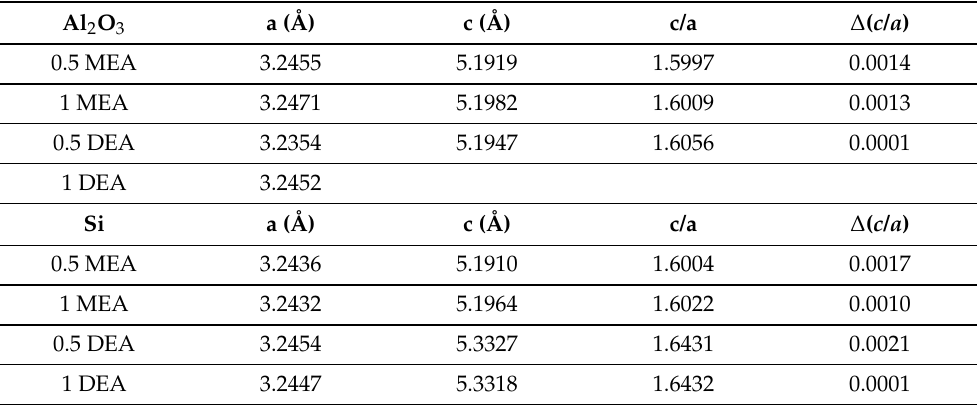
Table 3. The estimation of lattice parameters for ZnO layers grown on specific